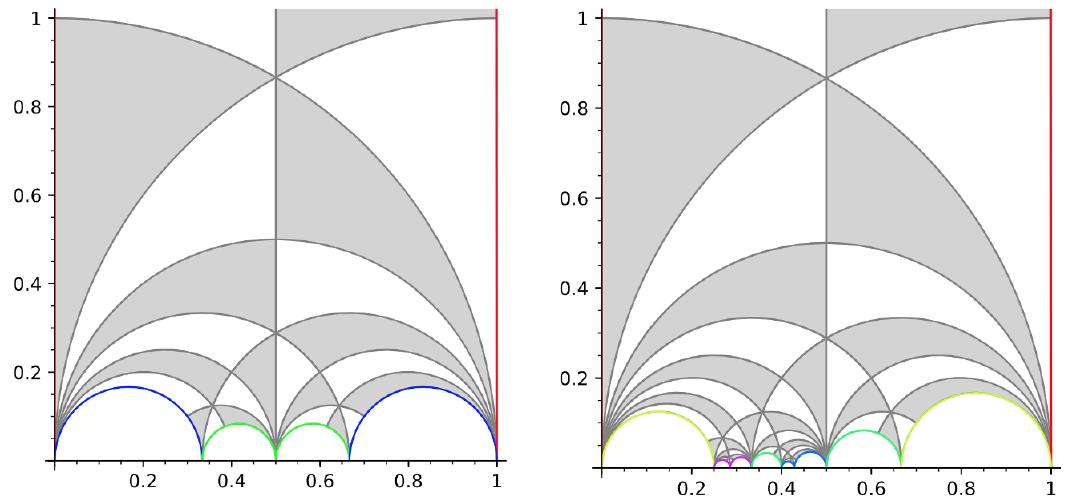
Figure 3 . Triangulation of X 1 (6) and X 1 (7). Sides with equal colors are to be